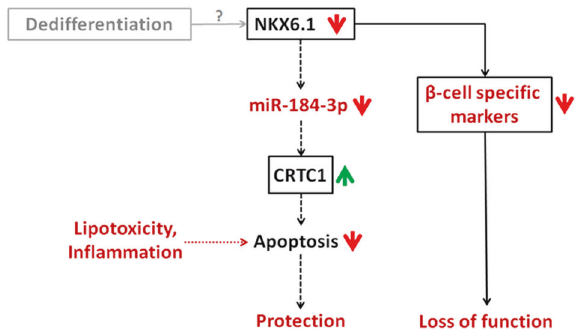
Fig. 7 NKX6.1-miR-184-3p-CRTC1 axis. Working model of upstream and downstream miR-184-3p molecular mechanisms in β -cells